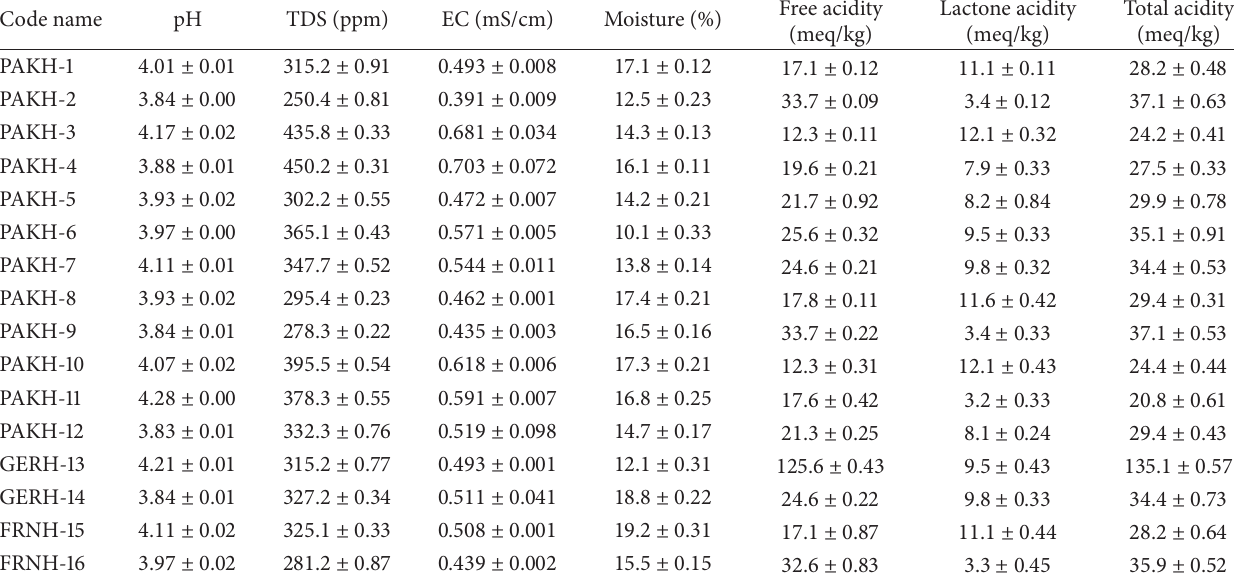
Table 1: pH, TDS, EC, moisture, free acidity, lactone acidity, and total acidity of honey samples (mean ± SD, 𝑛 = 3